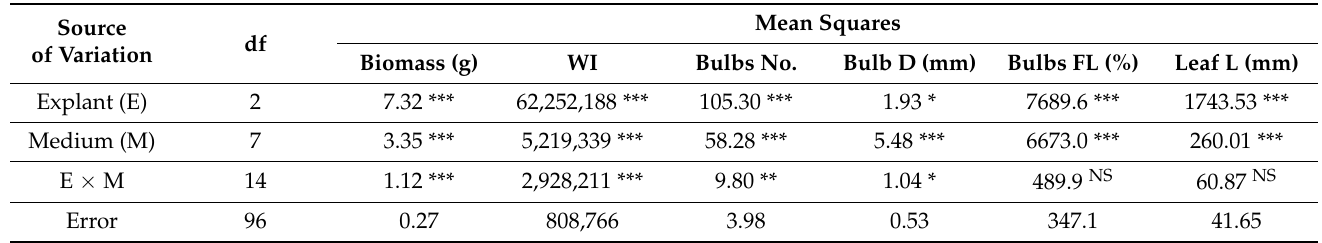
Table 2. Two-way ANOVA results indicating the main effects of explant type, medium and their interaction on studied